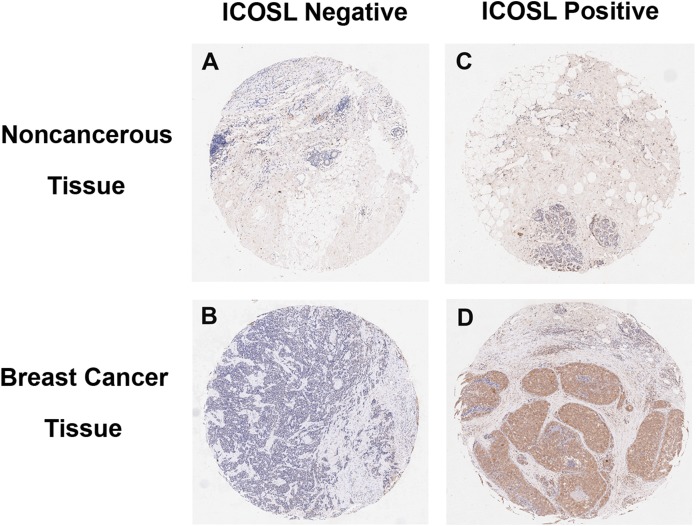
Representative images of breast cancer immunostaining for ICOSL in cancerous and noncancerous tissues (10× magnification).(A) Negative for adjacent noncancerous tissues. (B) Negative for adjacent cancerous tissues. (C) Positive for adjacent noncancerous tissues. (D) Positive for breast cancer tissues. ICOSL staining was shown as the brown color in the images.